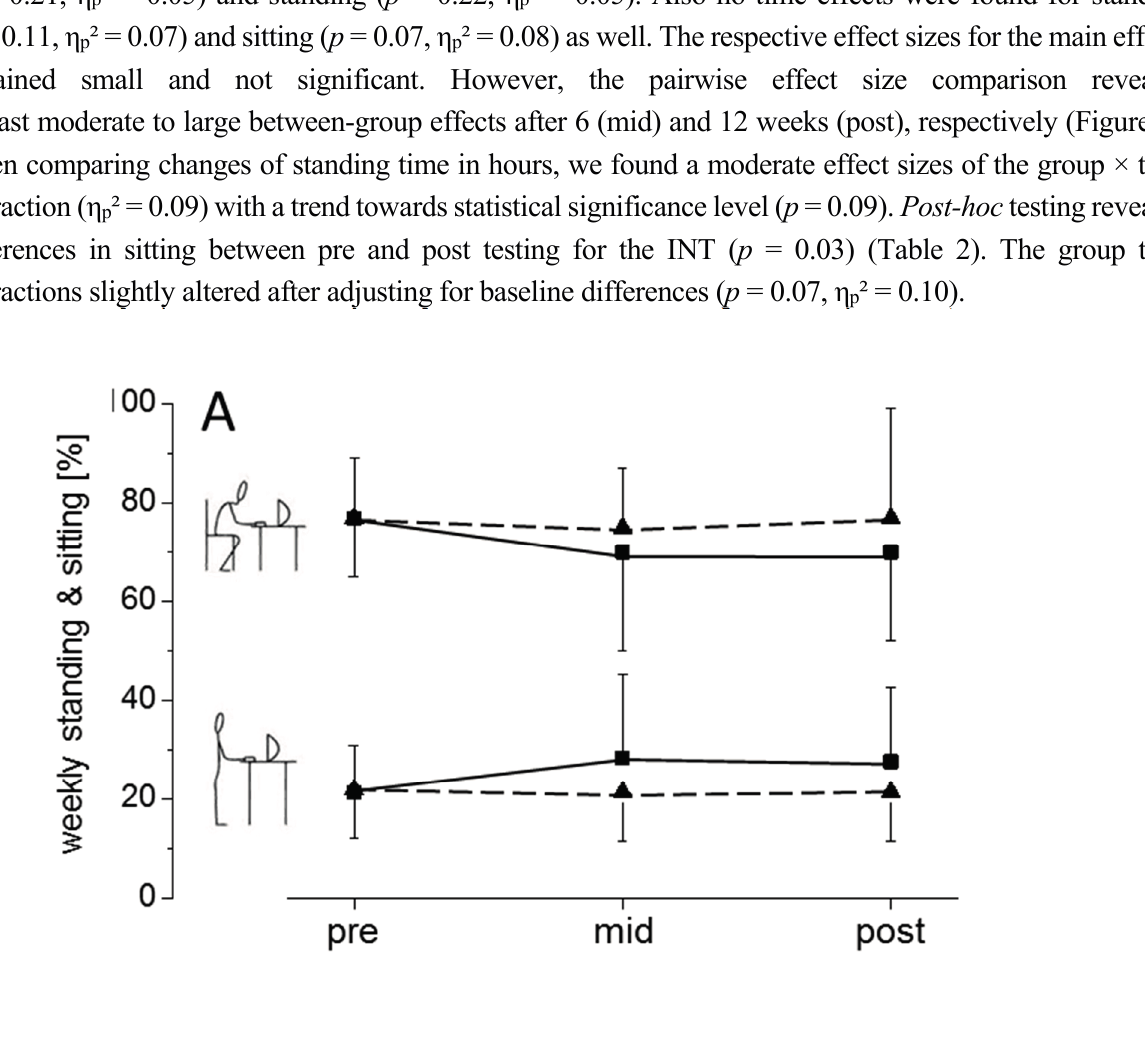
Figure 2. Percentage of occupational sitting and standing time at pre, after 6 weeks (mid) and 12 weeks (post) for INT (squares with solid line) and CON (triangles with dashed line). Data are depicted as means and standard deviations (SD). Pairwise effect sizes are provided as standardized mean differences (Cohen’s